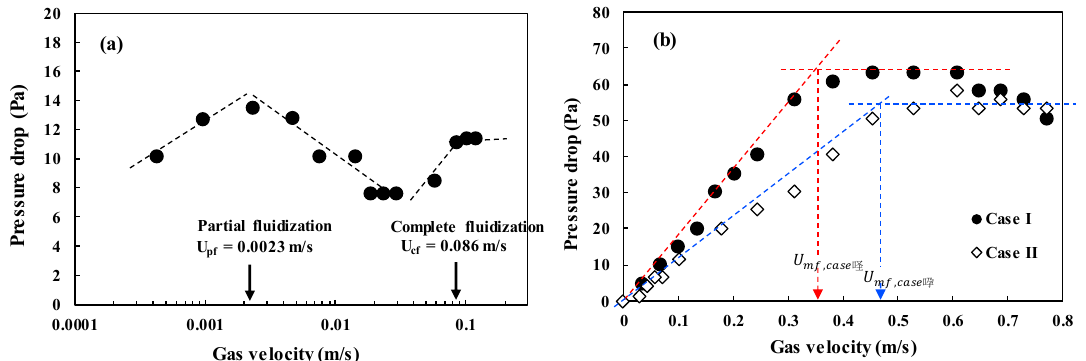
Figure 6. Pressure drop-versus-velocity diagram: ( a ) raw CNT powder and ( b ) CNT microbeads.